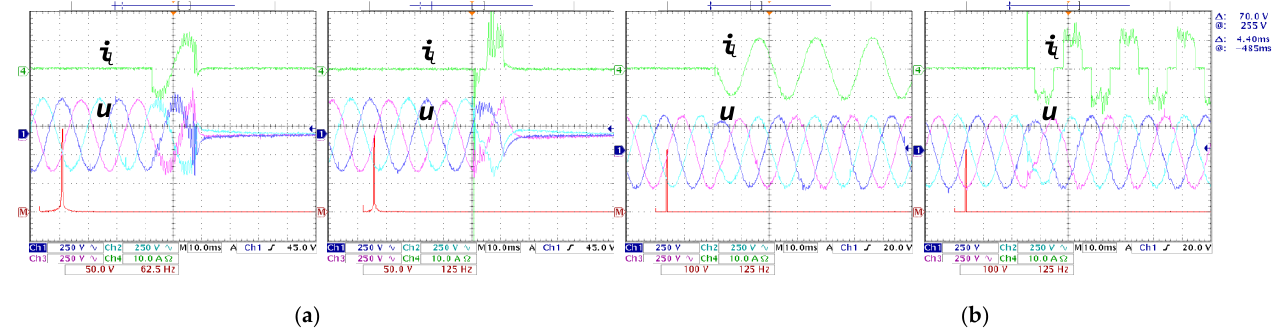
Figure 10. Dynamic waveforms of the method proposed in 26 with different LC filter parameters: ( a ) 2 mH, 30 μF (nominal); ( b ) 2 mH, 60 μF.